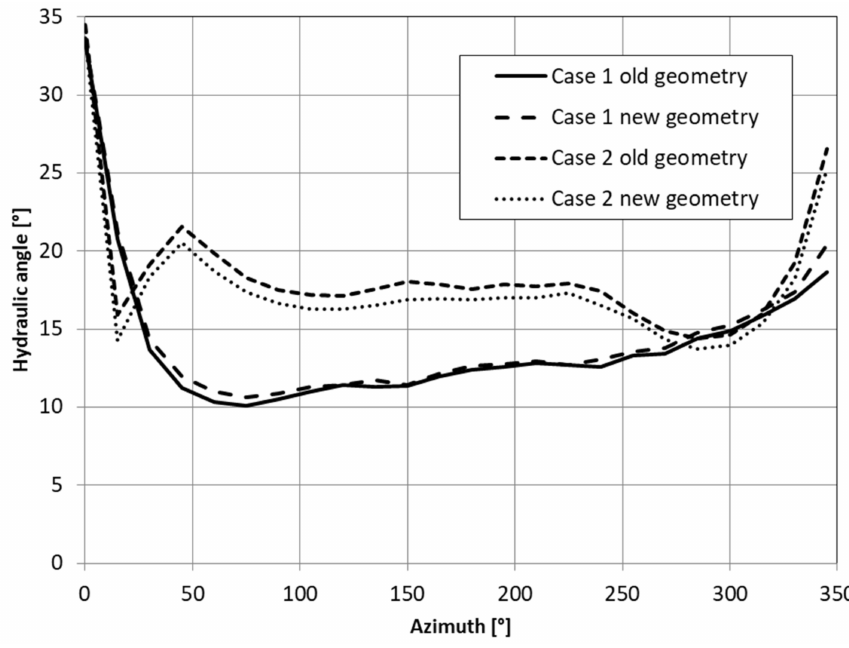
Figure 16. Flow orientation at SV leading edge of the two studied hydraulic turbines.